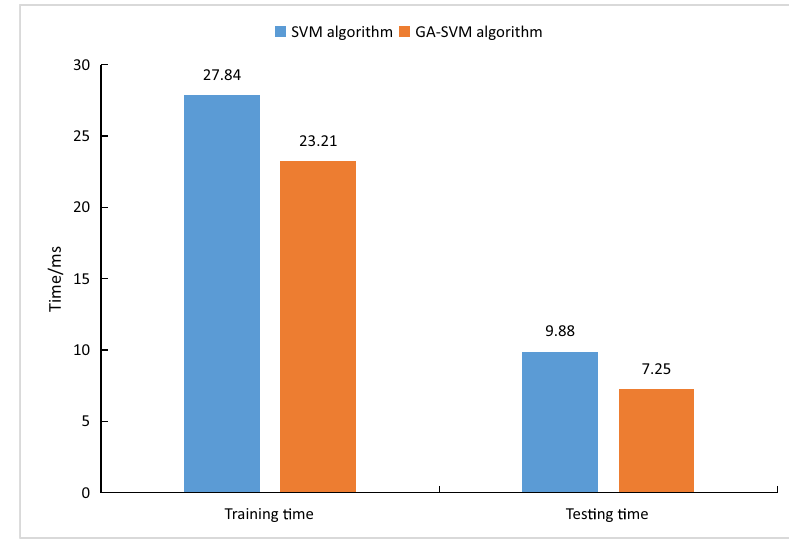
Figure 1: Comparison of the running time between